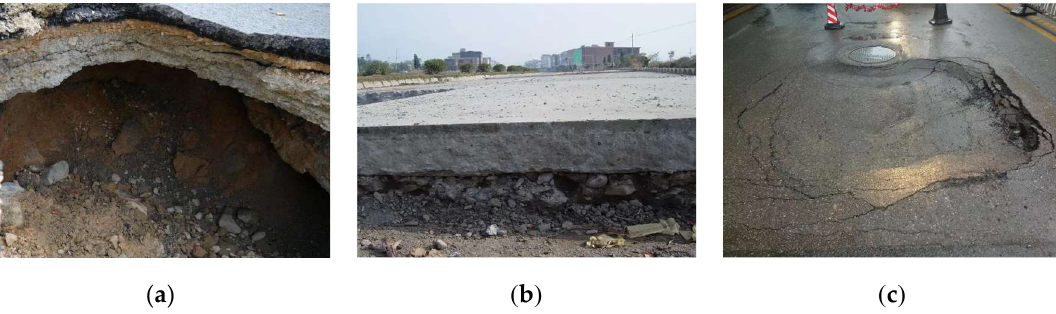
Figure 1. Common road diseases. ( a ) Subgrade debonding; ( b ) Subgrade weakness; ( c ) Road subsidence.